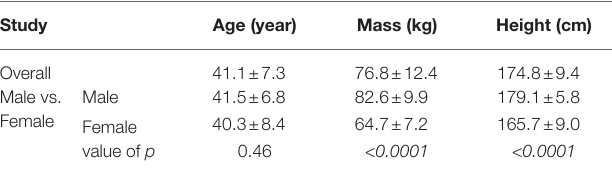
TABLE 1 | Mean participant characteristics and statistical significances between